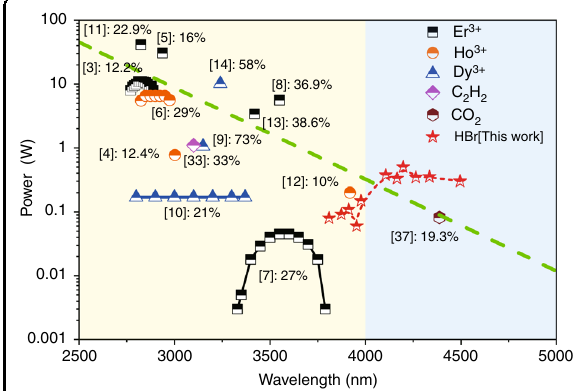
Fig. 1 Summary of the state-of-art CW mid-IR fi bre lasers in terms of output power and lasing wavelengths. The solid lines with symbols represent the continuously tunable output while the dotted line with symbols in this work represents the step-tunable output. The green dashed line is the fi t of the data except for tunable results. The exponential decrease in output power with the emission wavelength is mainly due to the increase in the quantum defect between the pump and laser photon energies at longer wavelengths. The percentage close to the reference numbers refers to the corresponding slope ef fi ciency. The red star symbols are the results in this work and two background light colours are employed to distinguish the wavelength boundary of 4 μ